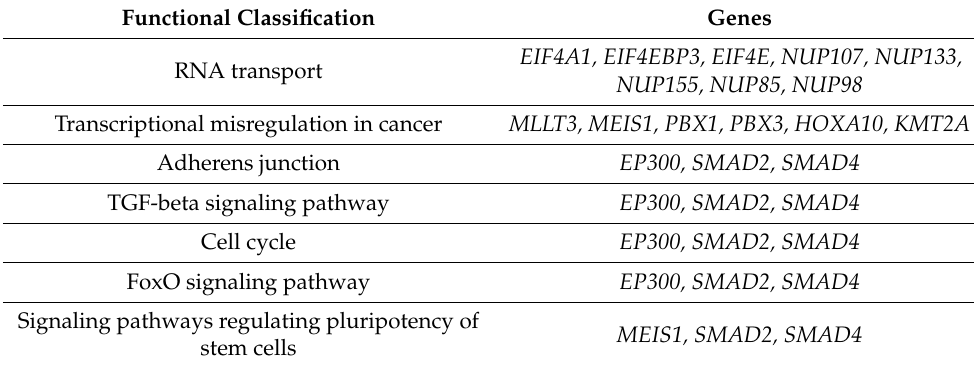
Table 2. List of genes under each functional classification as described in Figure 5B.